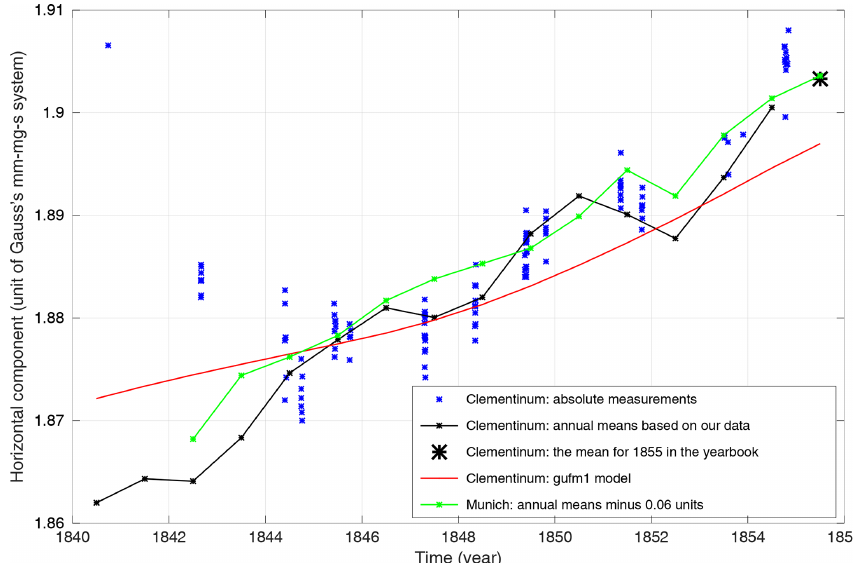
Figure 6. The comparison of the absolute values of the horizontal intensity observed at Clementinum (absolute measurements – blue; annual means calculated by us – black curve; the annual mean for 1855 taken from the yearbook – black asterisk) with the annual means of the horizontal intensity in Munich reduced by 600nT (i.e., 0.06 absolute units in mm–mg–s). The red curve is the horizontal intensity for Prague provided by the gufm1 model (Jackson et al., 2000).